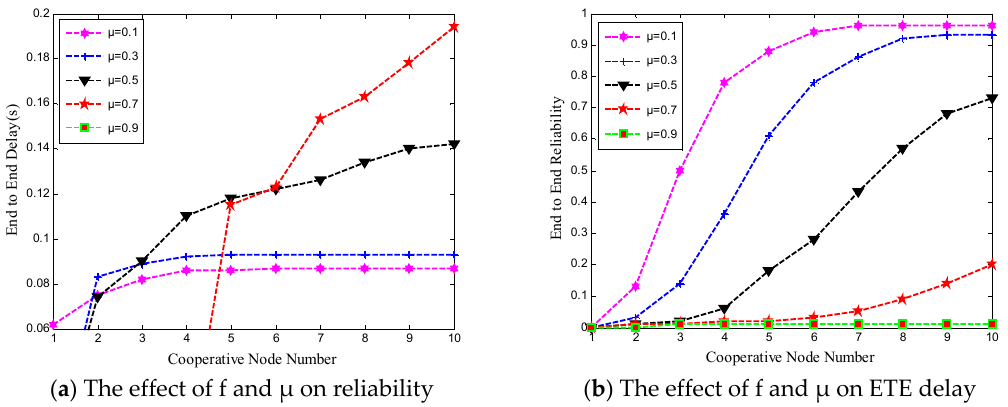
Figure 8. The effect of f and μ on W. Figure 8. The e ff ect of f and µ on W.